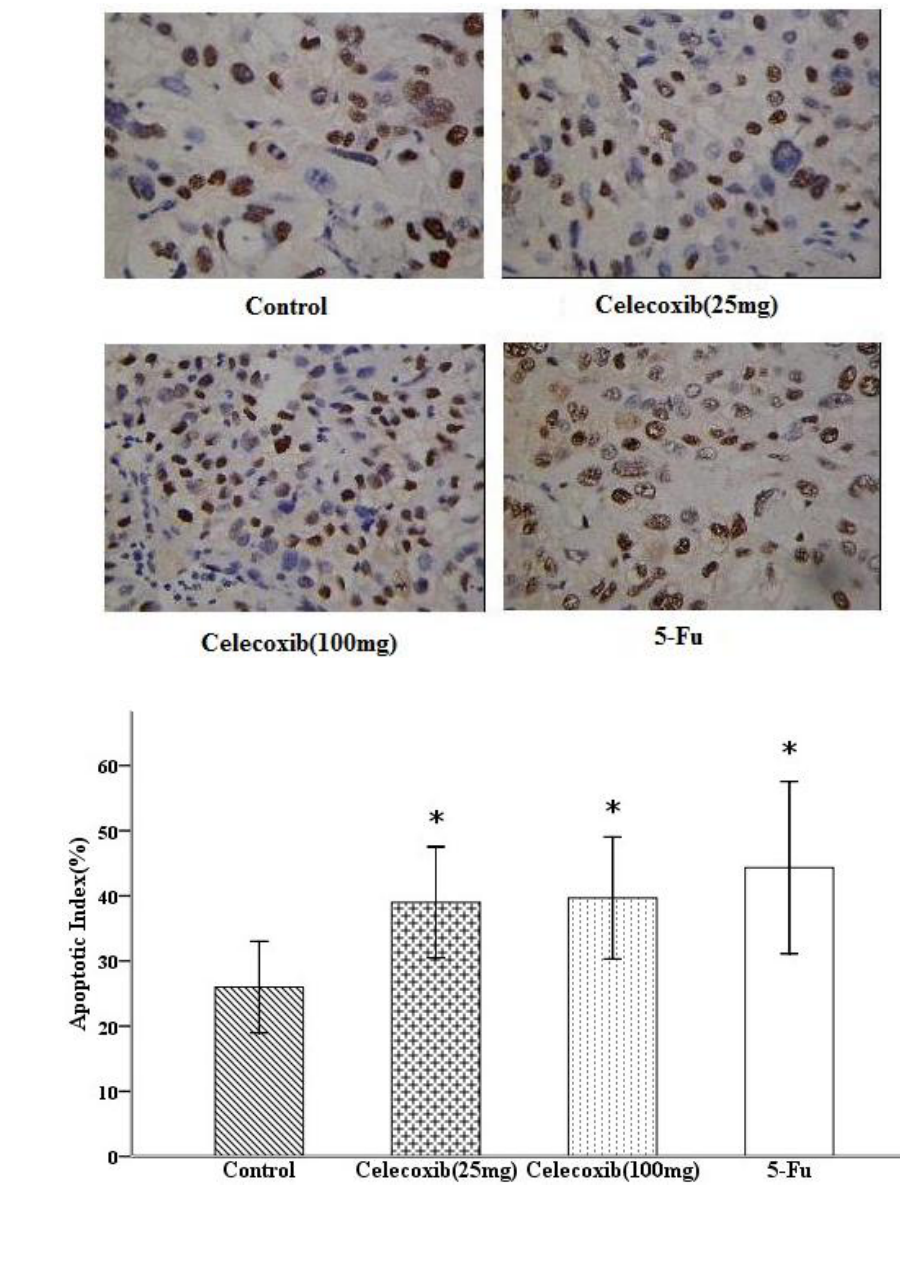
Figure 4. COX-2 inhibitor effect on the apoptosis of tumors. ( A ) Apoptotic cells of tumor tissue. Light microscopic image of TUNEL-positive cells visualizing apoptosis from ovarian tumor sections isolated from vehicle, 5-Fu and 25, 100 mg/kg Celecoxib-treated mice. Brown, apoptotic cells. All images are representative of five standardized fields from six separate mice. Magnification ×400. ( B ) Apoptotic index. Quantitative data for apoptotic index is shown as percent TUNEL-postive cells. Apoptotic index illustrates the apoptotic indution of Celecoxib on tumors. * P < 0.05 compared with control, error bars indicate